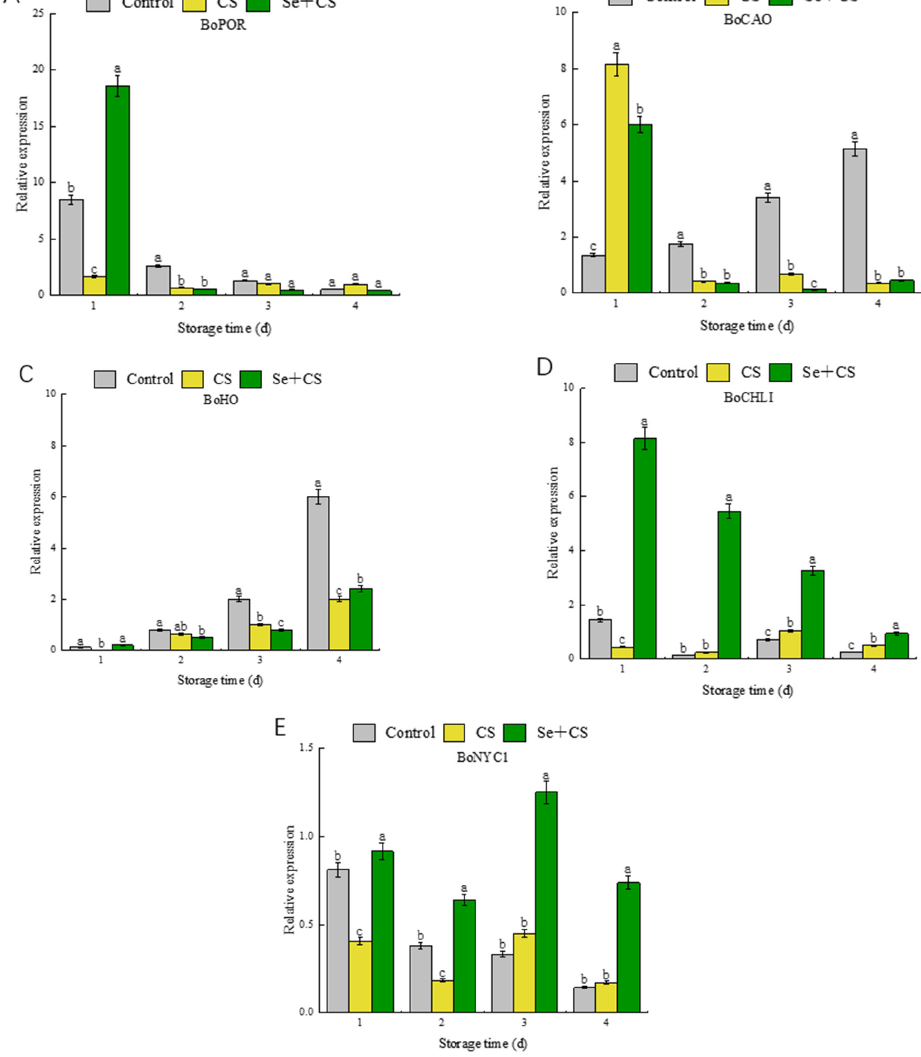
Figure 4. Relative gene expressions of chlorophyll metabolism-related genes in broccoli treated with Se+CS during storage. ( A ). BoPOR . ( B ). BoCAO . ( C ). BoHO . ( D ). BoCHLI . ( E ). BoNYC1 . Different letters represent significant differences in the same group during storage ( p < 0.05) by Duncan’s multiple range test.